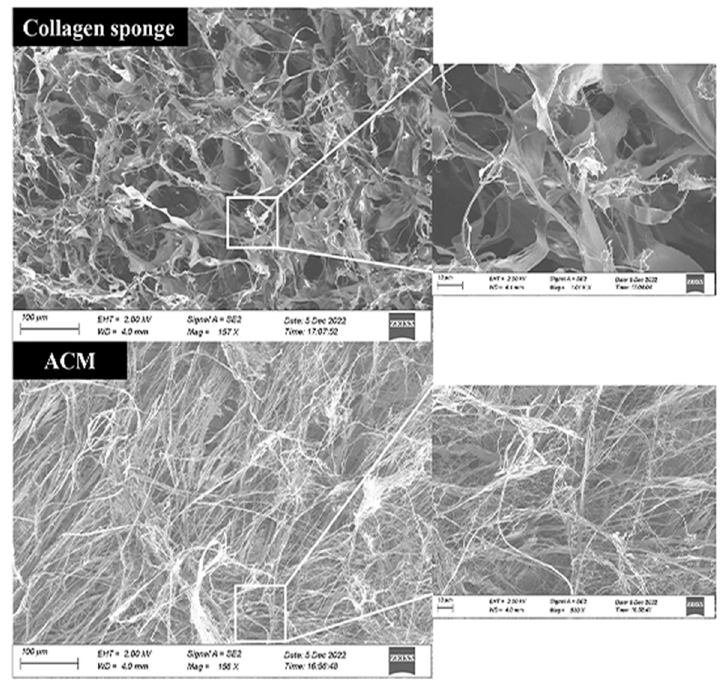
Figure 2. SEM images of collagen sponge and ACM